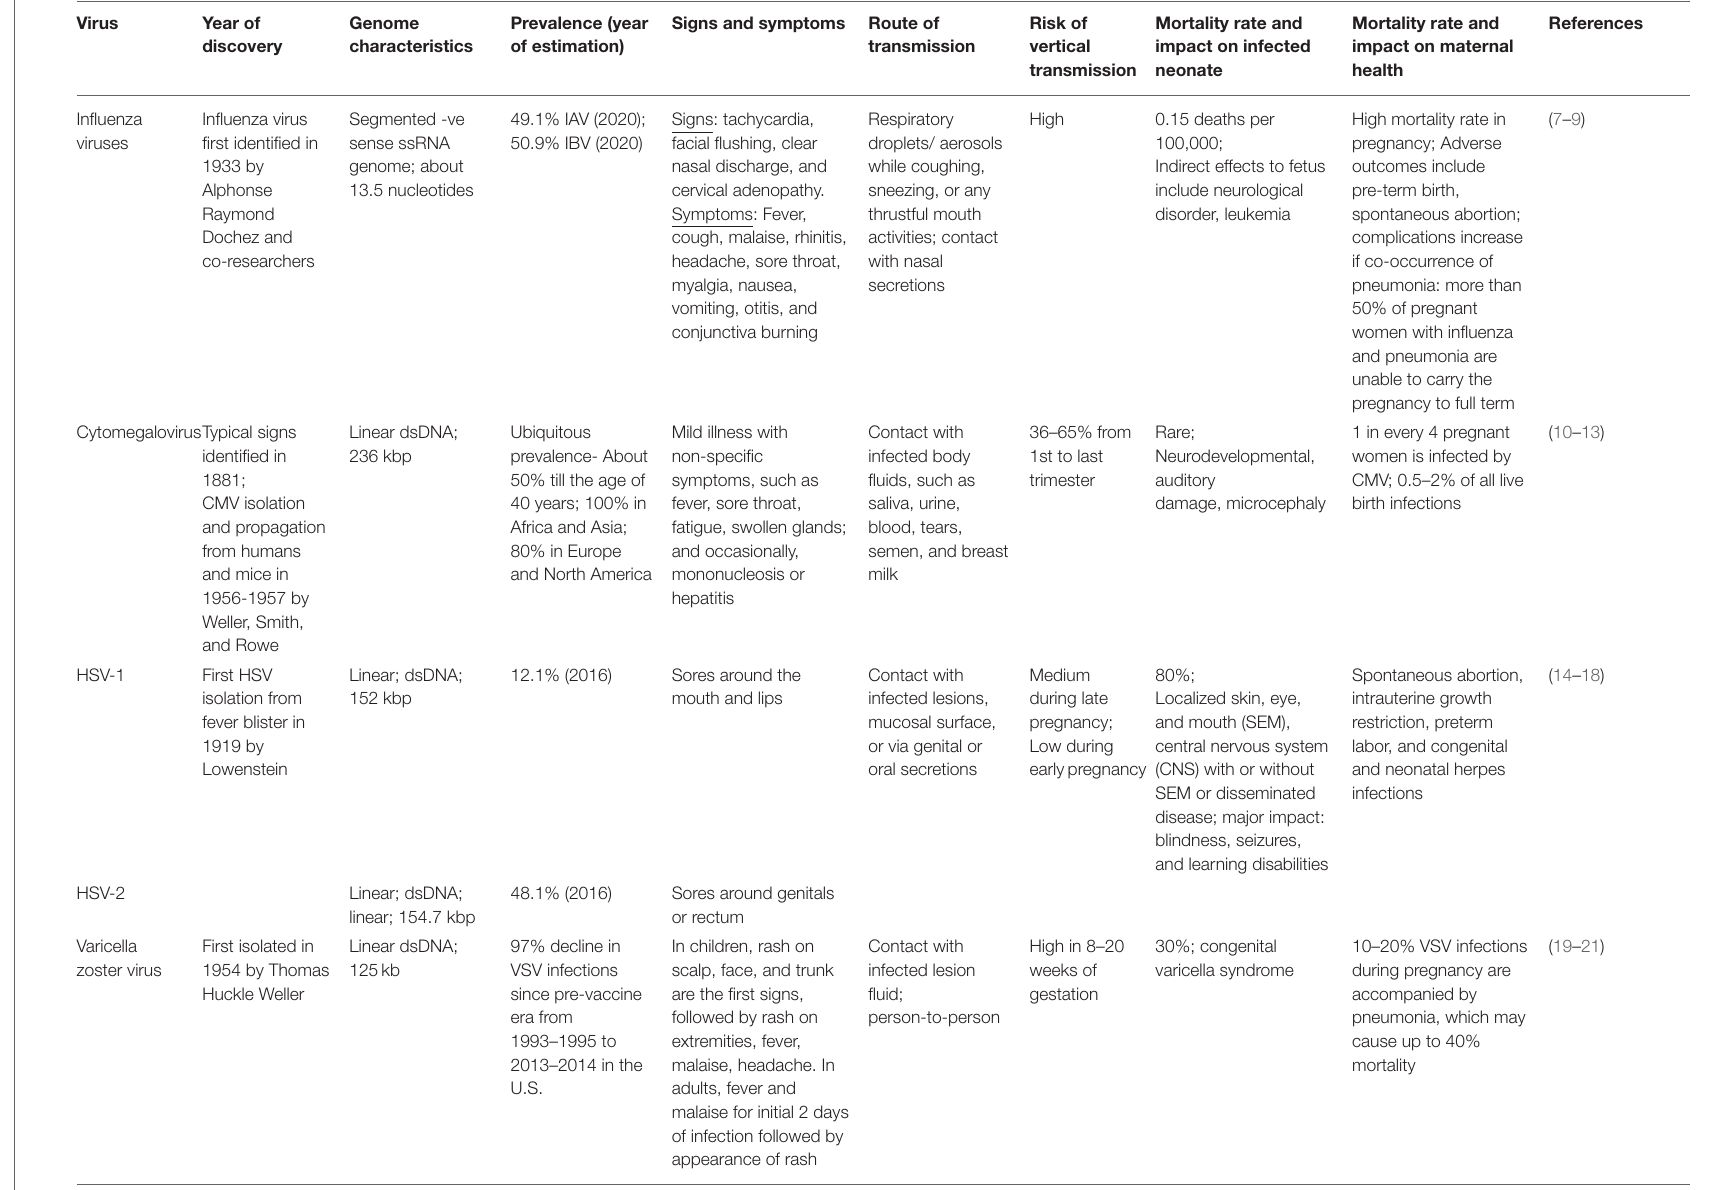
TABLE 1 | Various features of virus infections during